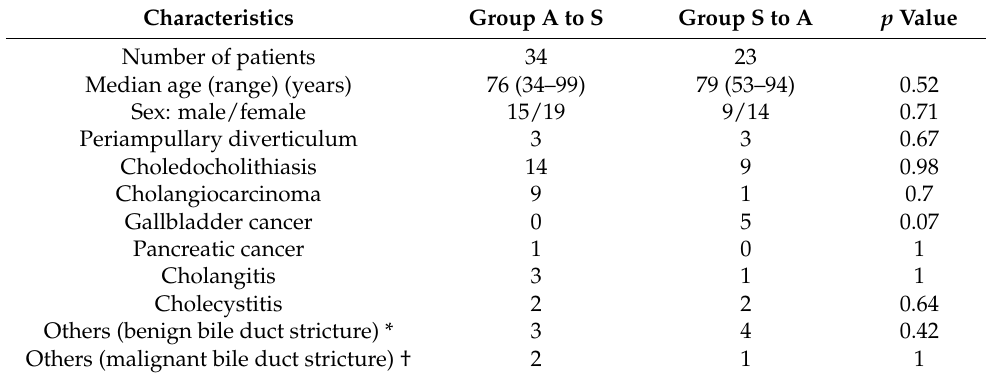
Table 1. Patient